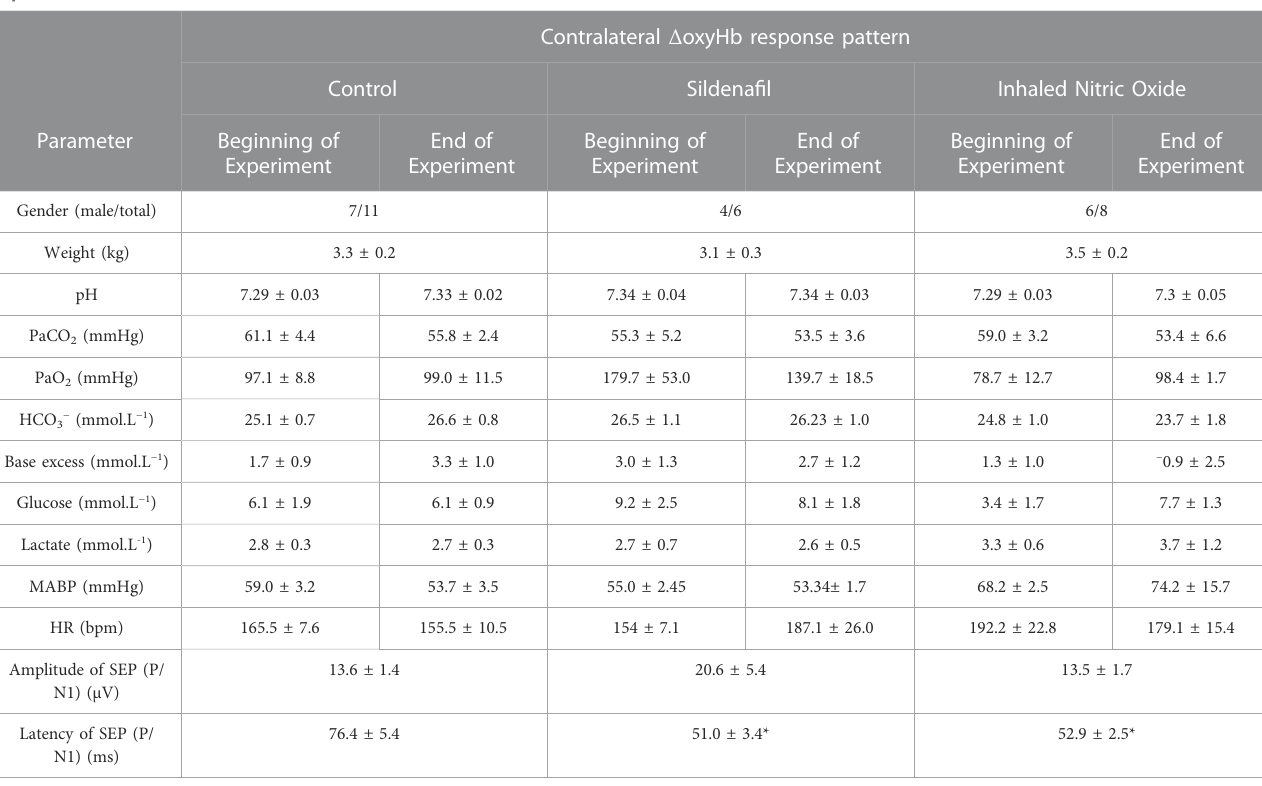
* indicates signi fi cant difference to control. p < 0.05.